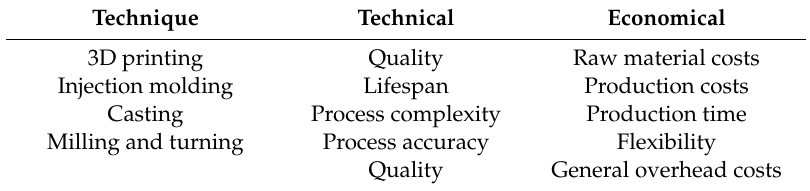
Table 4. Indicative technical and economic criteria for manufacturing technique of reactors [101,103–106]. Technique Technical Economical 3D printing Quality Injection molding Lifespan Casting Process complexity Milling and turning Process accuracy Flexibility